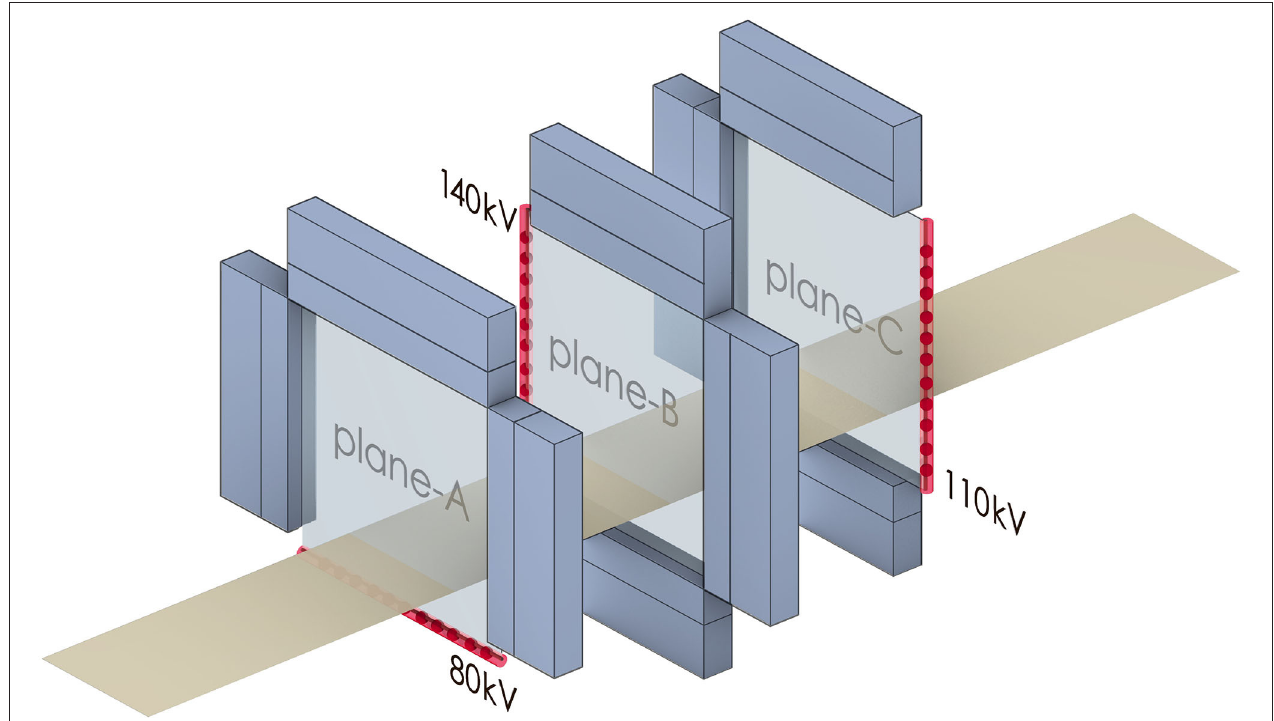
FIGURE 1 | The diagram of the TPCT system. The blue blocks represent the sandwich detectors. The red lines and dots represent the carbon nanotubes and source spots. The yellow belt represents the